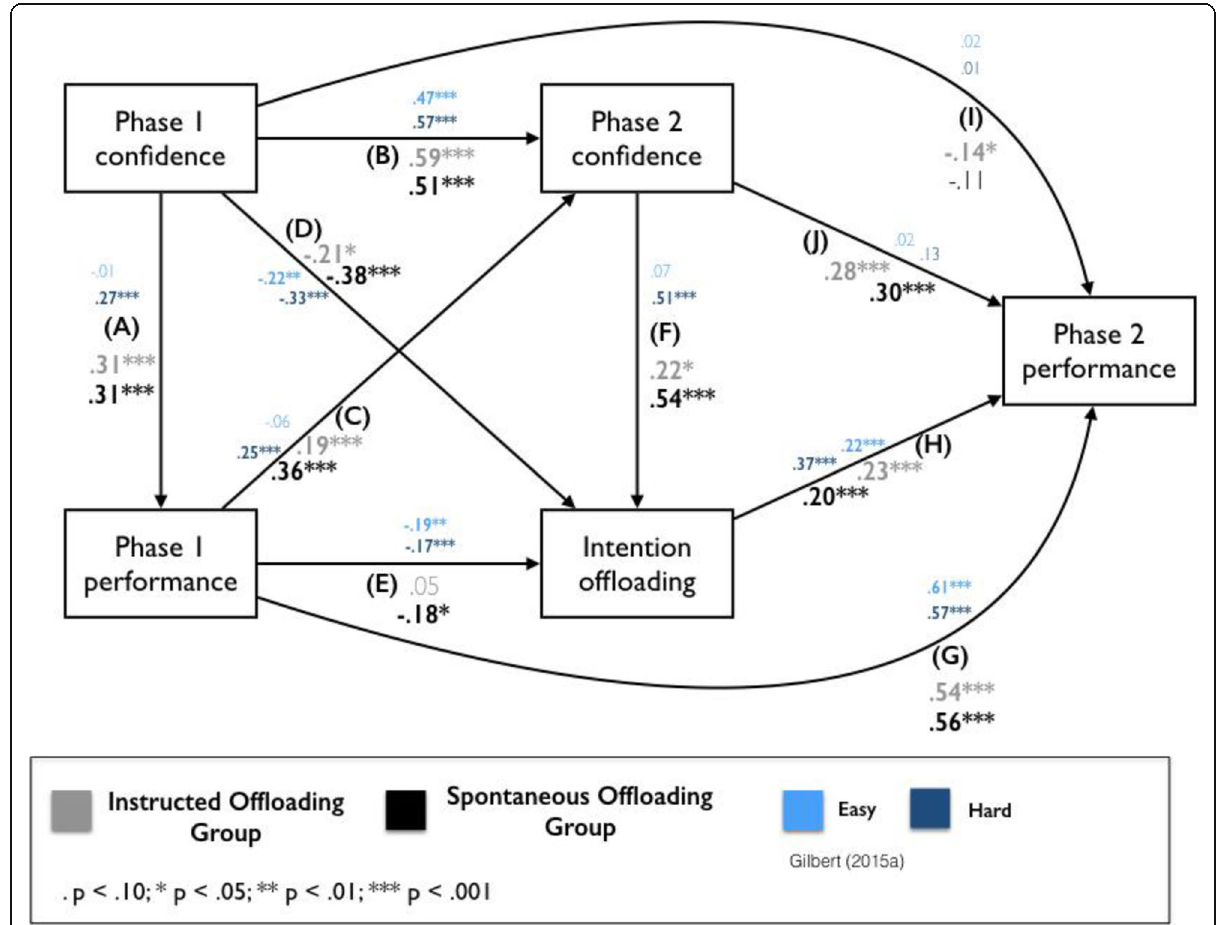
Fig. 5 Path analysis model of the relationships between different measures recorded during the study. Standardised beta weights for the Instructed Offloading Group are shown in grey. Weights for the Spontaneous Offloading Group are shown in black. Results for Gilbert (2015b) are shown in blue. Boldface indicates a reliable path